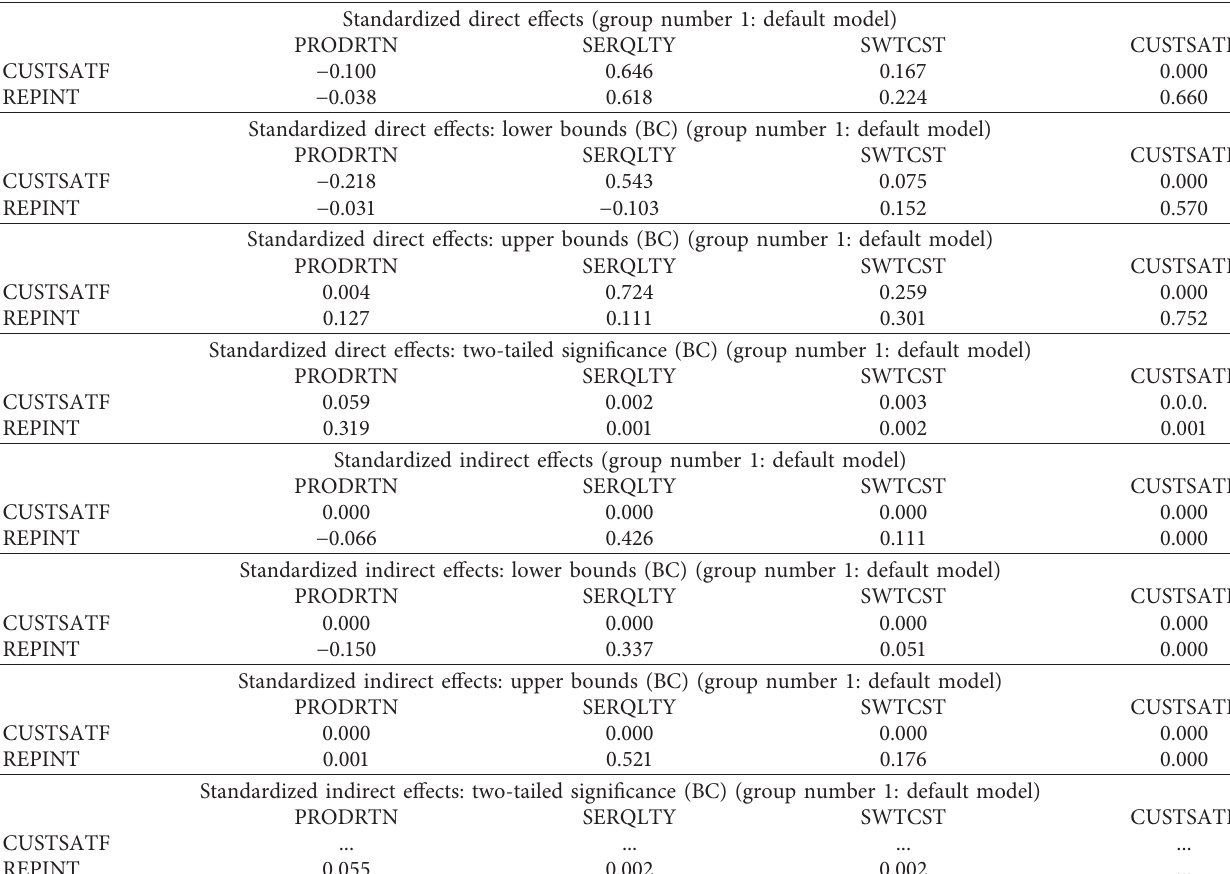
Table 12: Standardized direct/indirect effects with two-tailed